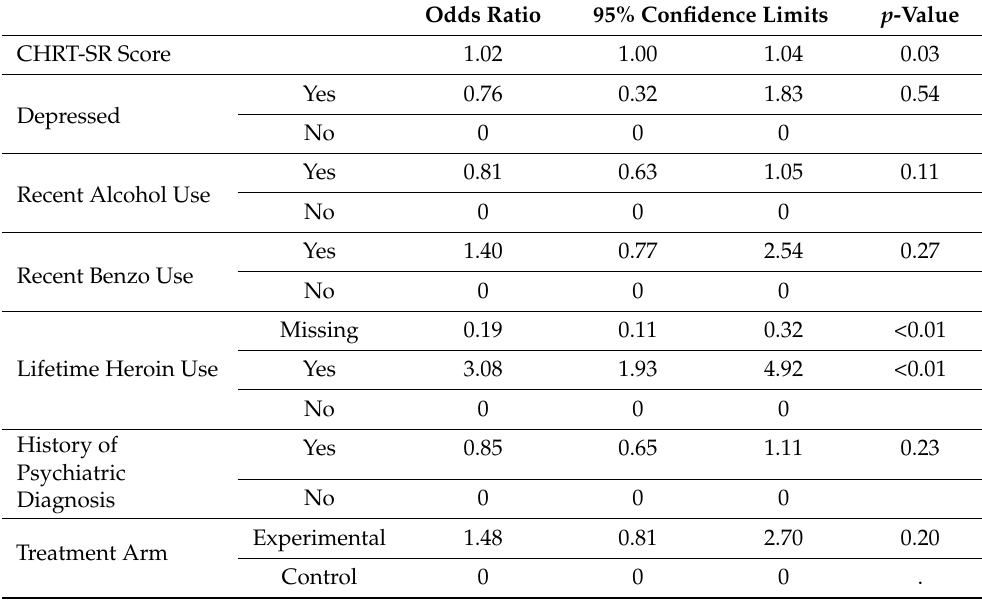
Table 3. Results of logistic regression/generalized estimating equation assessing CHRT-SR as a continuous predictor of